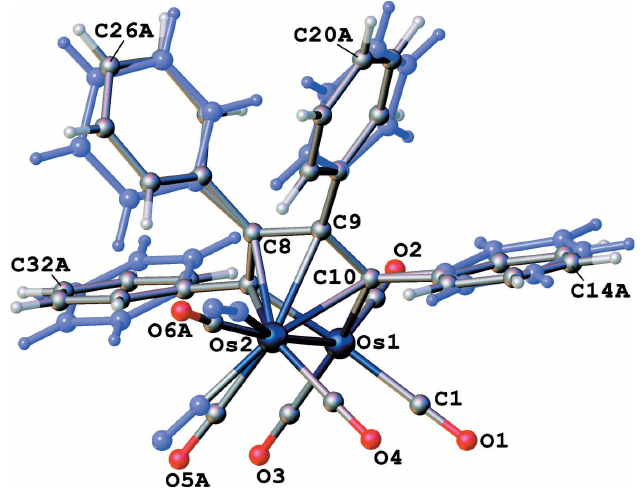
Figure 2 A ball-and-stick view of the asymmetric unit of III , with partial atom labeling. All components of the disordered carbonyl ligands and phenyl rings are shown (the minor ones in pale